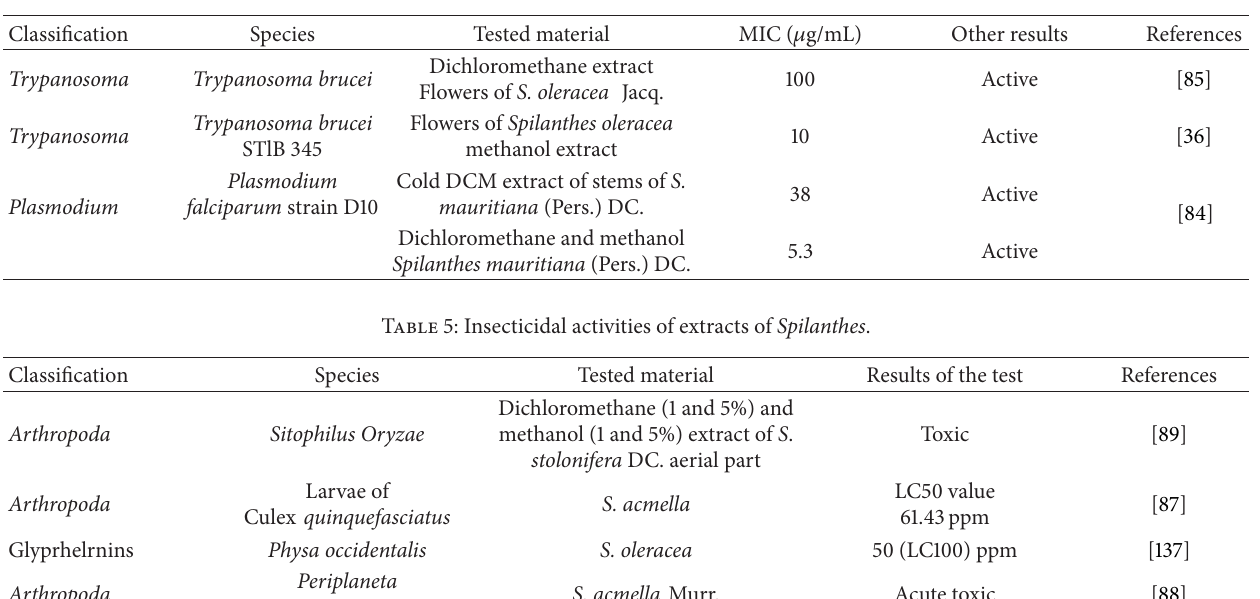
Table 4: Antiparasitic activities of extracts of Spilanthes .